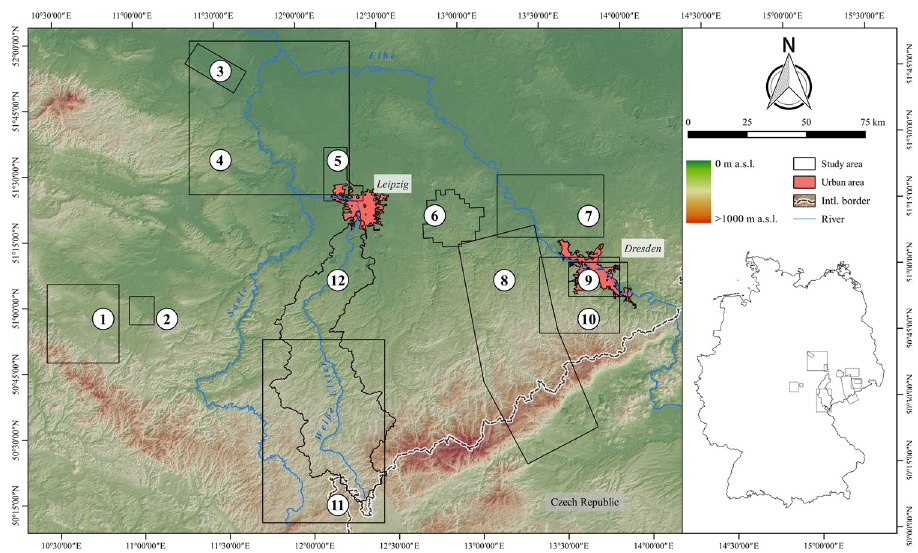
Fig 10. Study areas in Central Germany mentioned in the text and in Table 3. (1) Gothaer Land [33], (2) Erfurt [200], (3) downstream section of the Bode river [201], (4) Elbe-Saale-Region [202], (5) North-West Saxony [57], (6) Lake Go¨ttwitz [101], (7) former district of Riesa-Großenhain [56], (8) Ore Mountains [203], (9) Dresden Elbe valley [41], (10) Dresden Elbe valley and lower part of eastern Ore Mountains [204], (11) Vogtland [171], (12) catchment of the Weiße Elster river (this